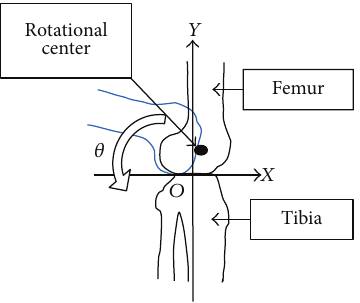
Figure 1: Coordination system of the tibia and femur [17].